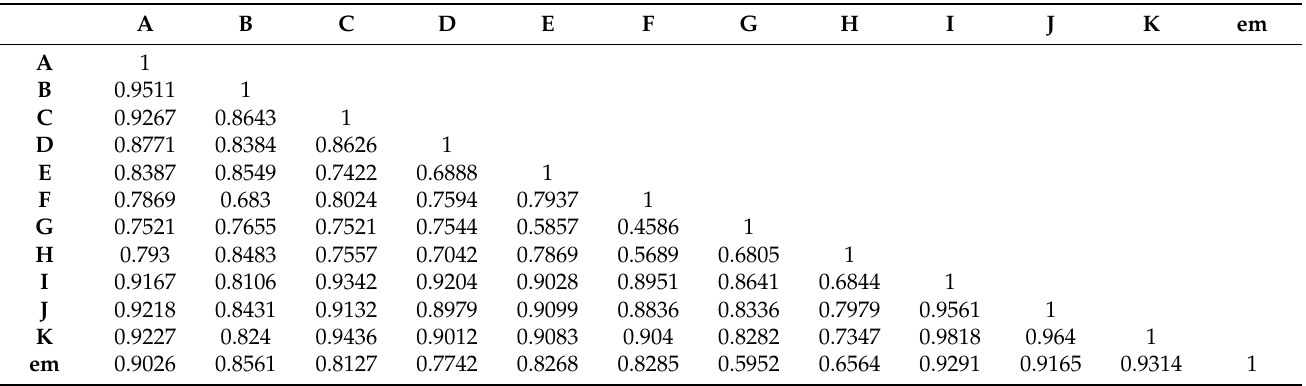
Table A2. Summertime (May–October) PM2.5 correlations between monitoring stations.